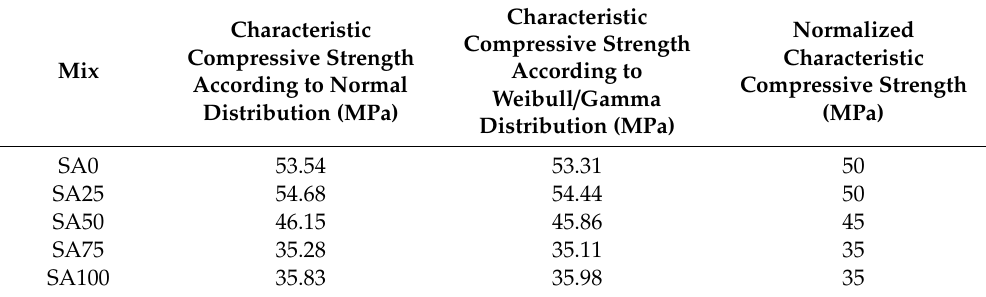
Table 16. Characteristic compressive strength of the mixes